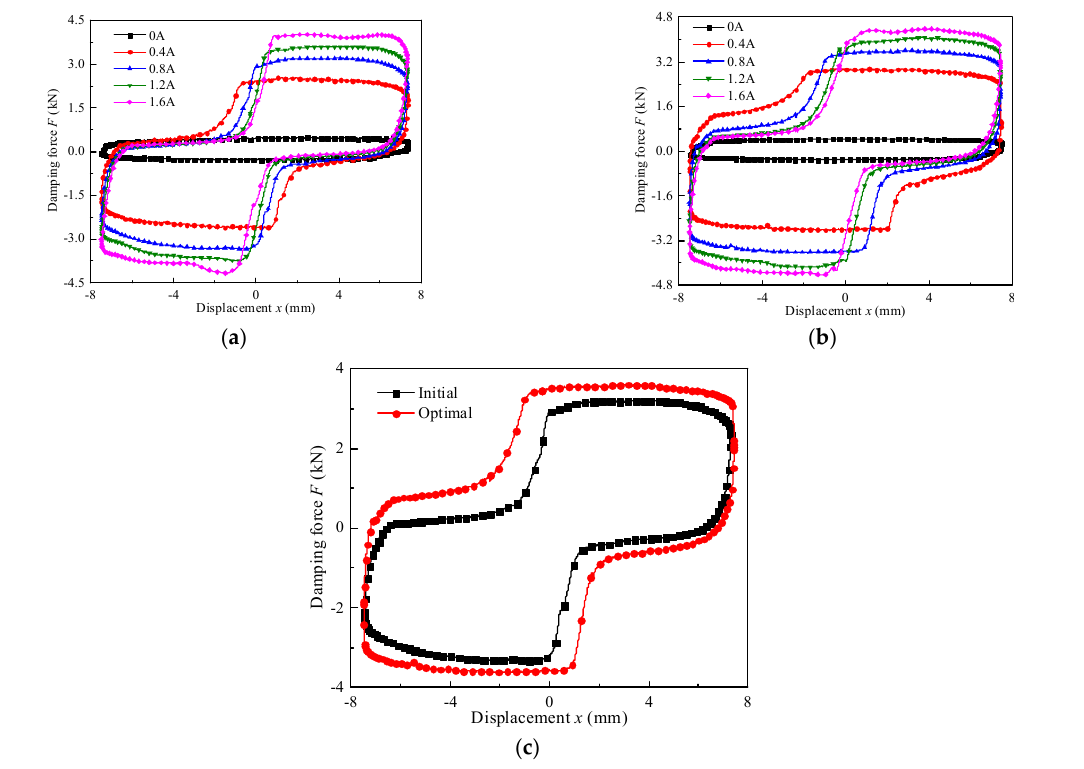
right parts, which is mainly due to the fact that a certain volume of air is mixed into the MR fluid during fluid filling, resulting in a small empty stroke of the valve-controlled cylinder system due to the failure to timely compensate for the missing fluid in the cham- ber during the up and down stretching process. When the excitation current is 0.8 A, the maximum damping force of the initial and optimal MR valve-controlled cylinder system are 3.18 kN and 3.55 kN, the maximum deviation of calculation results for the initial and optimal output damping force is 11.62%.